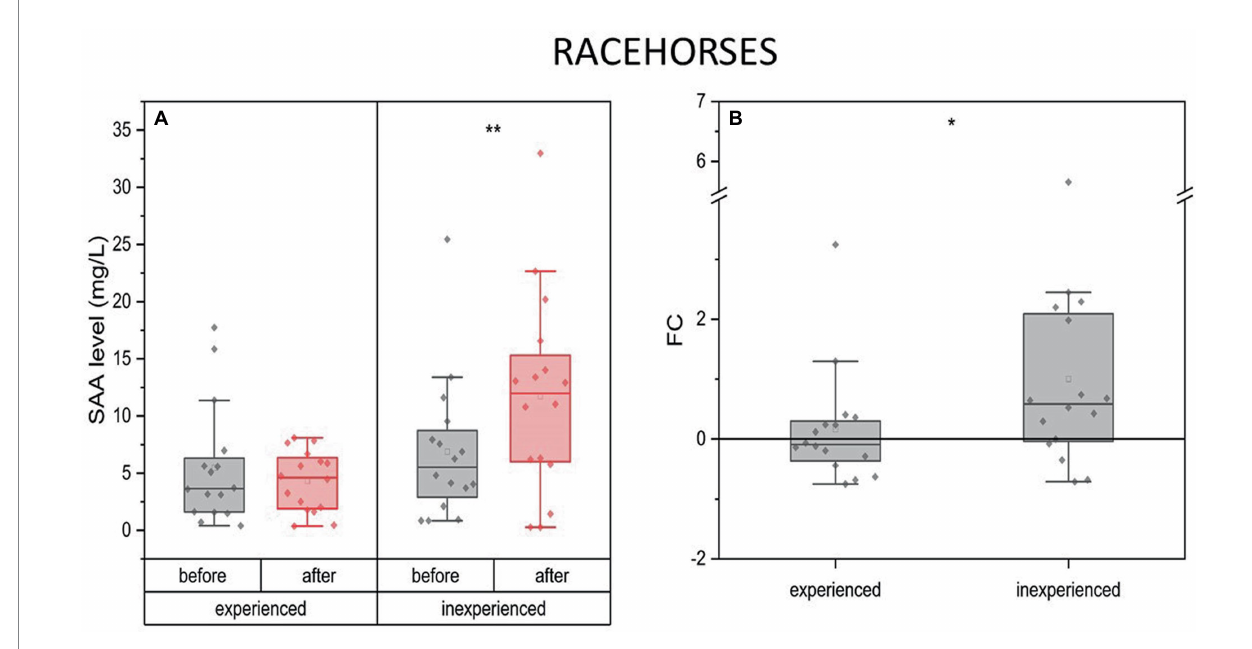
FIGURE 7 Changes in SAA plasma concentration upon training in experienced ( n = 16) and inexperienced ( n = 16) racehorses. Box plots (IQR, mean and median; whisker range within 1,5IQR) are expressed as the ratio of hormones’ molar plasma concentration (A) and fold change (FC) (B) . Statistically significant differences are indicated by asterisks at p < 0.05 (*), p < 0.01 (**), and p < 0.001 (***).